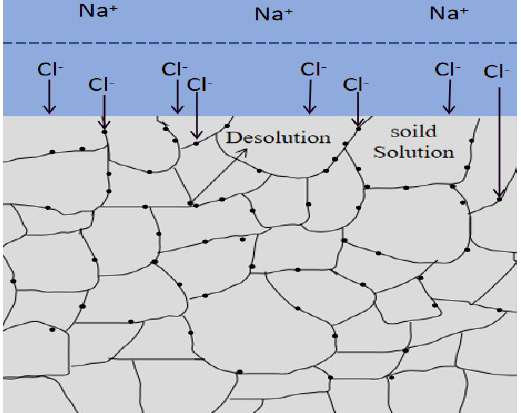
Figure 11. Schematic of the corrosion process of CoCrFeNiMn HEA coating in 3.5 wt.% NaCl solu-